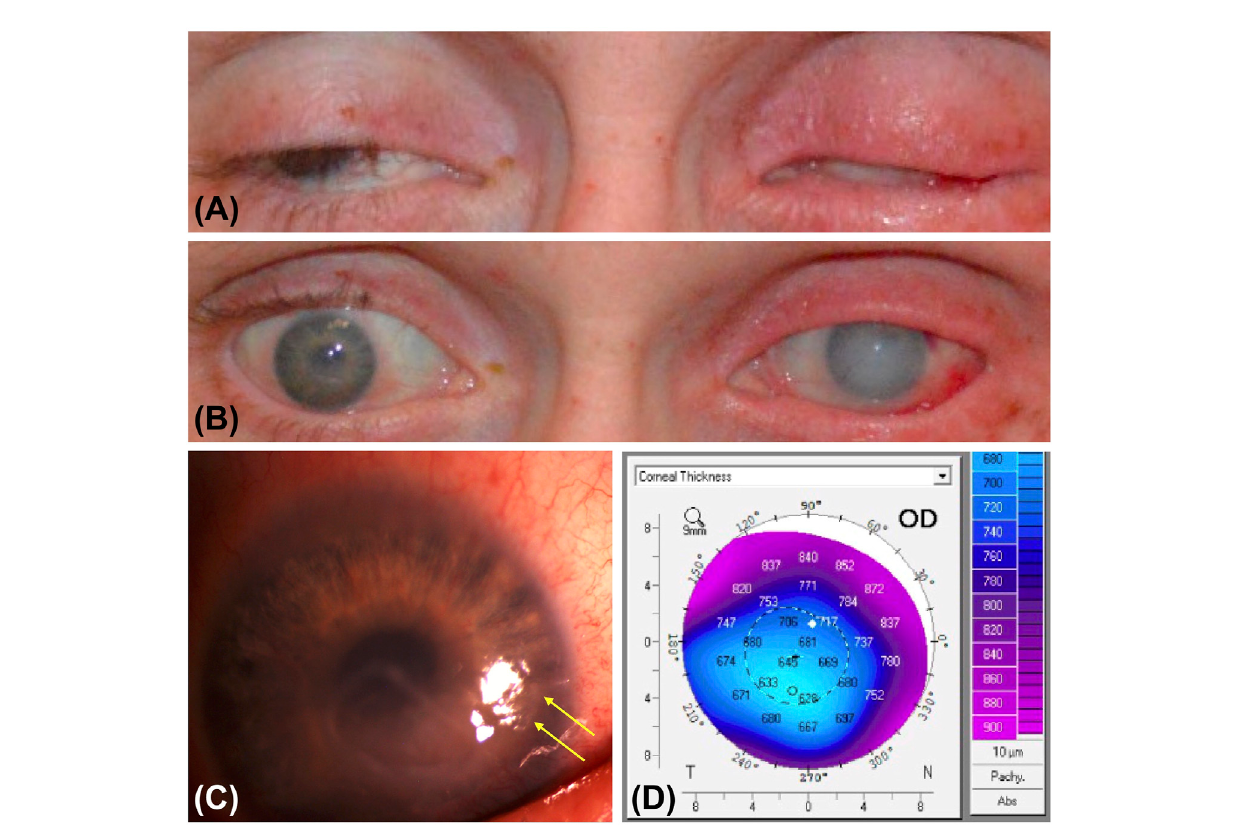
Photographic features and imaging fi ndings of a patient with methamphetamine associated keratitis. (A) External photograph of eyes closed show bilaterallagophthalmos,erythema,andlidthickening.Thereishypotrichosisoftherighteyelidandmadarosisofthelefteyelid. (B) Externalphotographof eyes open show conjunctival hemorrhage and diffuse corneal edema greater in the left than in the right eye, perilimbal injection in the right eye, and subconjunctival hemorrhage in the left eye. (C) Slit lamp photograph of the right eye shows residual corneal ulceration with thickened margins and areaofdesiccation(yellowarrows). (D)